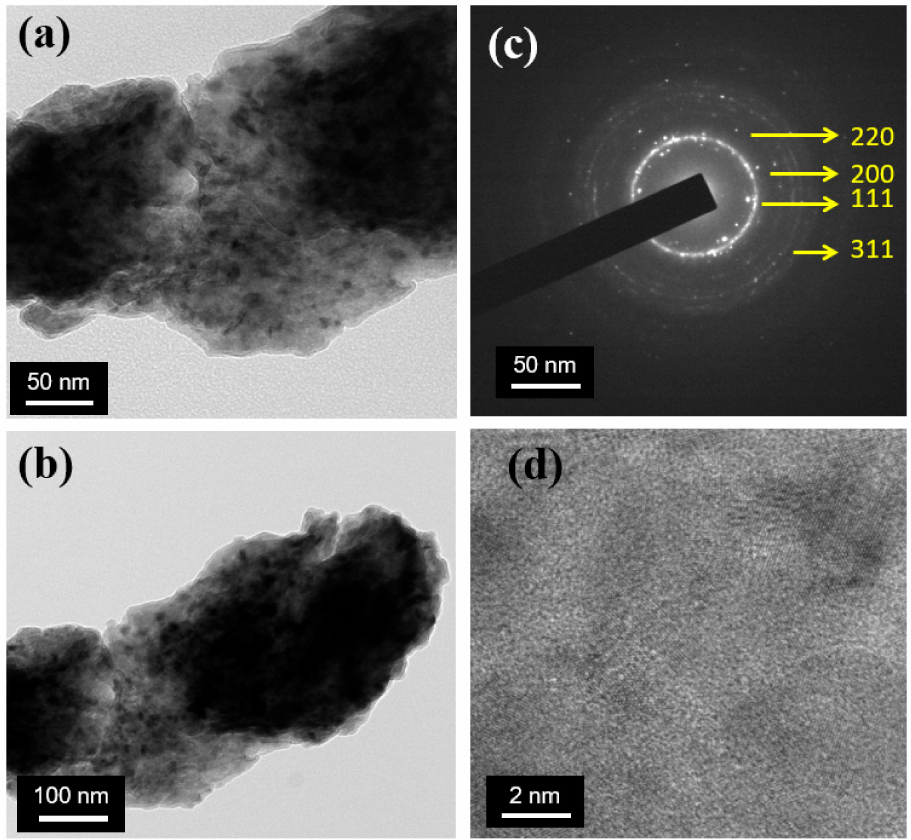
Figure 6. TEM micrograph of ball-milled powder (Cu-5 wt% B-10 wt% Ti): ( a , b ) represents overall bright-field images; ( c ) electron diffraction pattern measured on the nanoparticle; ( d ) lattice fringes of the